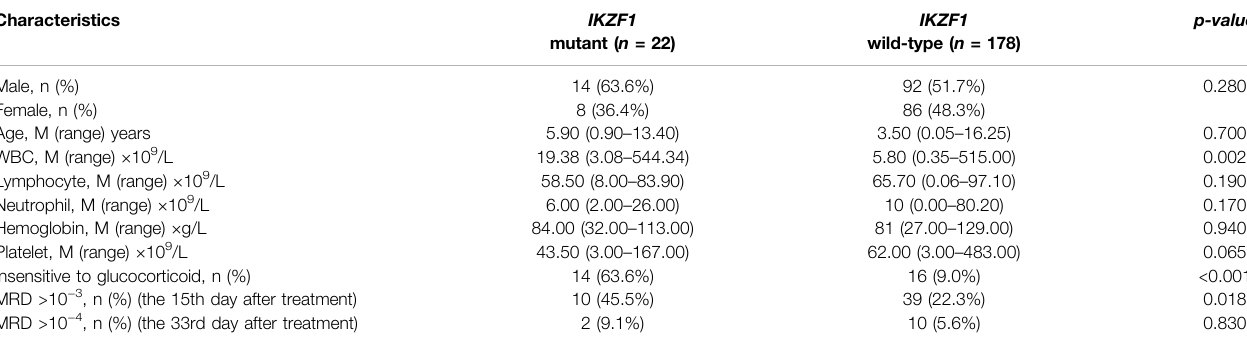
TABLE 2 | Comparison of clinical and genetic features between IKZF1 mutant and wild-type patients.